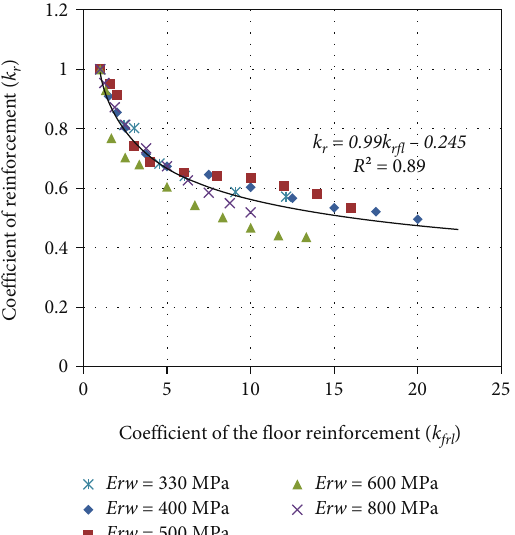
Figure 17: Correlations between coe ffi cient of reinforcement ( k and coe ffi cient of the fl oor reinforcement ( k rfl ) for di ff erent elastic modulus of the wet surrounding rock mass ( E wr ).